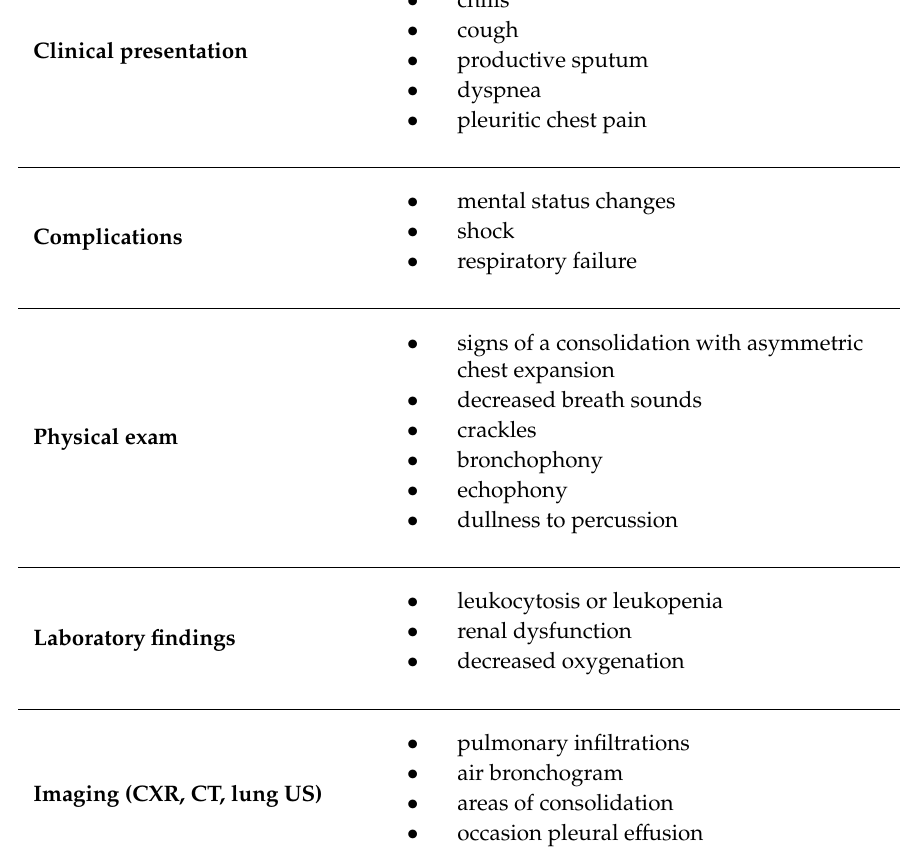
Table legend. CXR: chest X-rays; CT: computerized tomography; US: